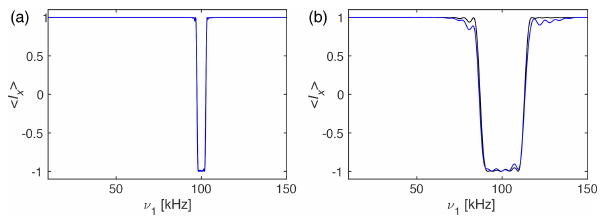
Figure 2. Plot of the expectation value (cid:104) I x (cid:105) as a function of the rf- field amplitude ν 1 in the range of 10 to 150kHz under an I-BURP-2 pulse in the spin-lock frame using ideal rf-field amplitudes (black) and scaled rf-field amplitudes (blue). The modulation frequency was set to ν mod = 100kHz and the pulse had a length of (a) 1ms and (b) 200µs corresponding to an inversion range of about 4 and 20kHz, respectively. One can clearly see the inversion band around the 100kHz modulation frequency, with virtually no artefacts out- side the inversion band. The black line corresponds to an ideal rf- field amplitude of the I-BURP-2 pulse of ν 2 = 1 /τ p , while the blue line uses ν 2 = (cid:0) 1 /τ p (cid:1) ( ν 1 /ν mod ), as would be the case in a real ex- periment with rf-field inhomogeneity. Simulations using circular- polarized radio-frequency fields that address the role of possible Bloch–Siegert effects can be found in Fig. S05.